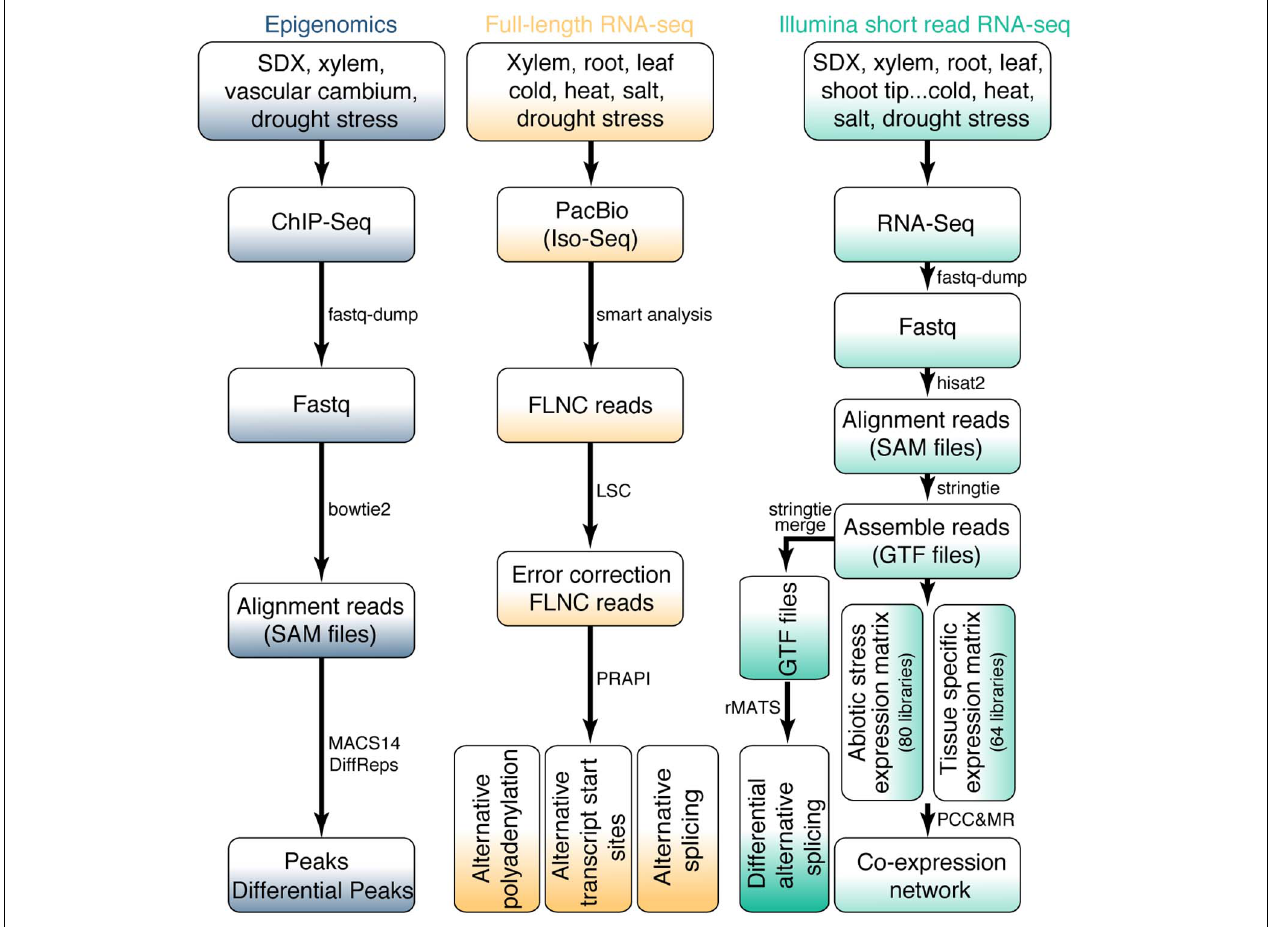
FIGURE 2 | Bioinformatics workflow for omics data. The upper part of the figure shows the data source for RNA-seq and epigenomics. The bioinformatics pipeline for all data processing is shown in the middle and bottom of the figure.